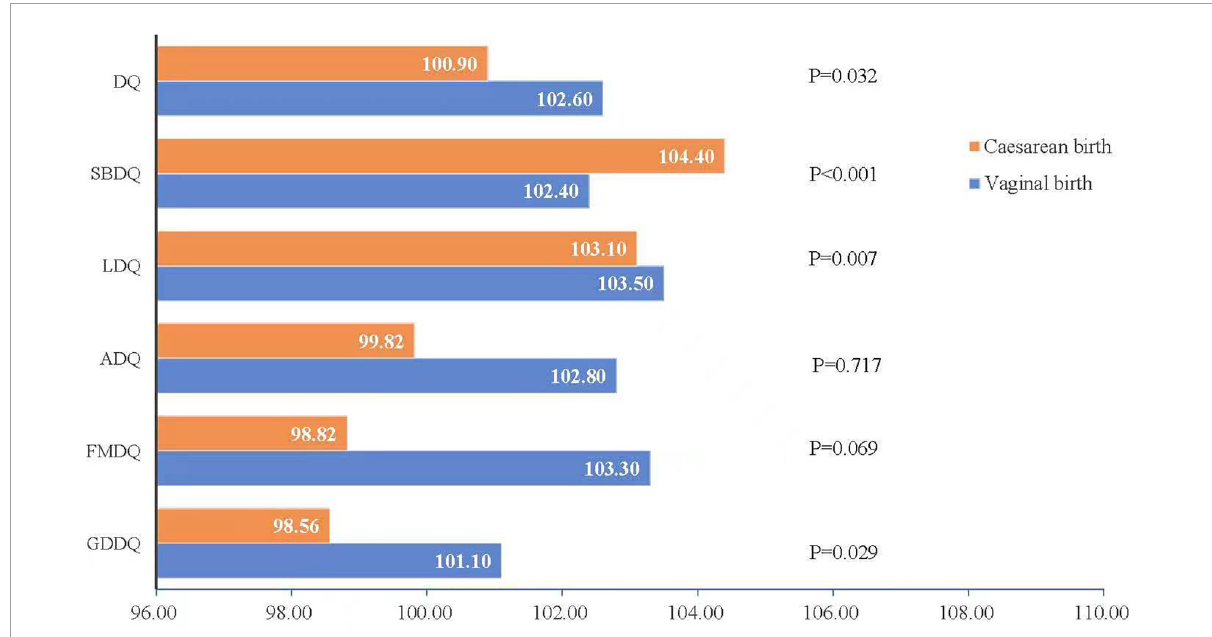
FIGURE1 Compare of the total and five subscale scores between cesarean section and vaginal